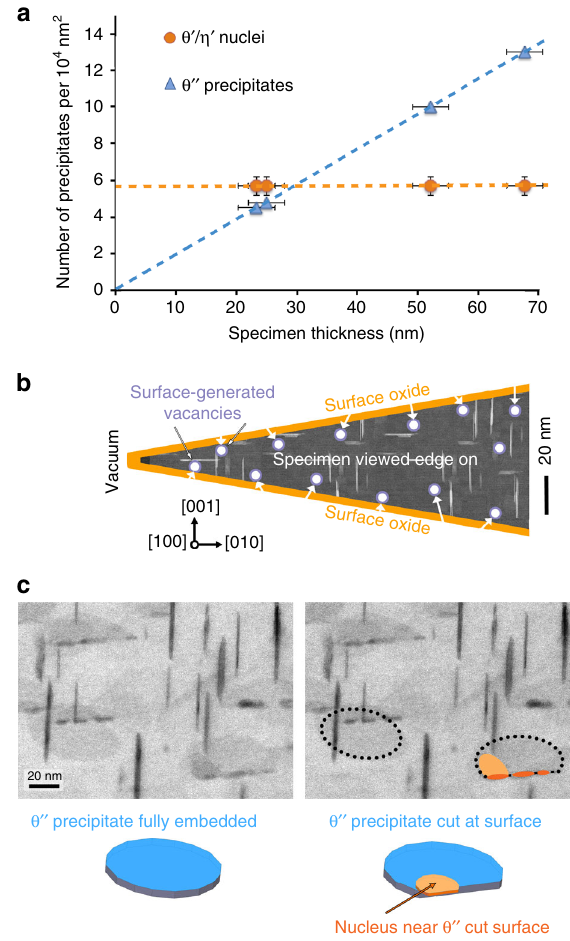
Fig. 3 TDN is enabled by vacancies generated at the surface of the nanometre-thick specimen. a Displays a plot of the number of θ ′ / η ′ nuclei and θ ″ precipitates per unit area of sample in plan view as a function of sample thickness, with error bars showing the standard deviation. The fact that the number of θ ′ / η ′ nuclei per unit area of sample is independent of thickness indicates that TDN nucleation is a surface or near-surface effect. b Shows a schematic illustration of the TEM specimen viewed edge on, with the thinnest section on the left, as imaged by HAADF-STEM. A signi fi cant proportion of θ ″ precipitates are either intersecting or within 5 nm of the surface and will, therefore, encounter surface-generated vacancies (shown as white disks in greatly exaggerated size). Note that the specimen ’ s wedge angle is depicted here much larger than in reality for the sake of clarity. c Shows one frame of a BF-STEM tilt series (see Supplementary Fig. 7), revealing that TDN occurs at the θ ″ precipitate cut surface where it meets the specimen surface circle in Fig. 4a) should greatly facilitate rearrangement of that plane into the stacking con fi guration of θ ′ (Supplementary Fig. 13c). Our density functional theory (DFT) calculations indicate that a vacancy at such a location will be favoured ener- getically by 0.08 ± 0.02 eV compared with a matrix vacancy at thermal equilibrium. A vacancy in the Al planes immediately below a Cu plane (pink circle in Fig. 4a and Supplementary Fig. 13f) should lower the energy barrier associated with the atomic shift of a Cu atom (see orange arrows, Fig. 4b and Sup- plementary Fig. 13f). Vacancies can also play a thermodynamic role through lowering the mis fi t strain of the nucleus, as illu- strated by the green circles in Fig. 4b and Supplementary Fig. 13e.